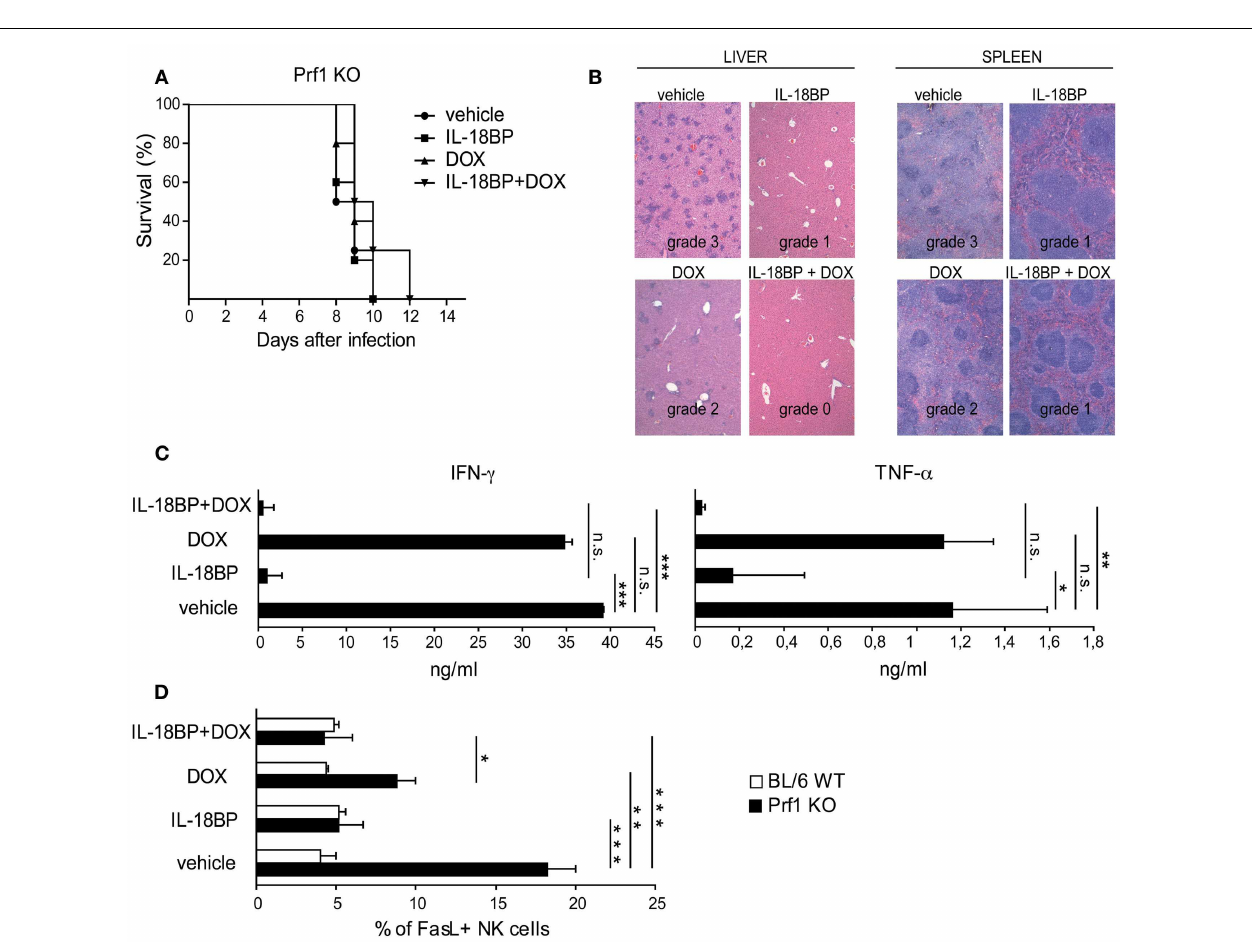
andTNF- α serum concentrations from Prf1 KO mice 6days after infection with DN-SCP-MCMV and treated with IL-18BP, DOX, or both. Mean ± SEM of three mice per group. * p < 0.05; ** p < 0.01; *** p < 0.001; n.s., not significant. (D) Fas ligand (FasL) expression in liver NK cells derived from Prf1 KO mice and BL/6WT mice 6days after DN-SCP-MCMV infection and treated with IL-18BP, doxycycline, or both. Mean ± SEM frequency of FasL positive NK cells in Prf1 KO mice and BL/6WT mice. N = 3 mice per group. * p < 0.05; ** p < 0.01; *** p <